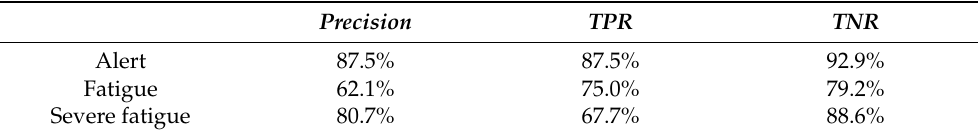
Table 6. k -nearest neighbor algorithm evaluation (the test results when the test accuracy reaches the